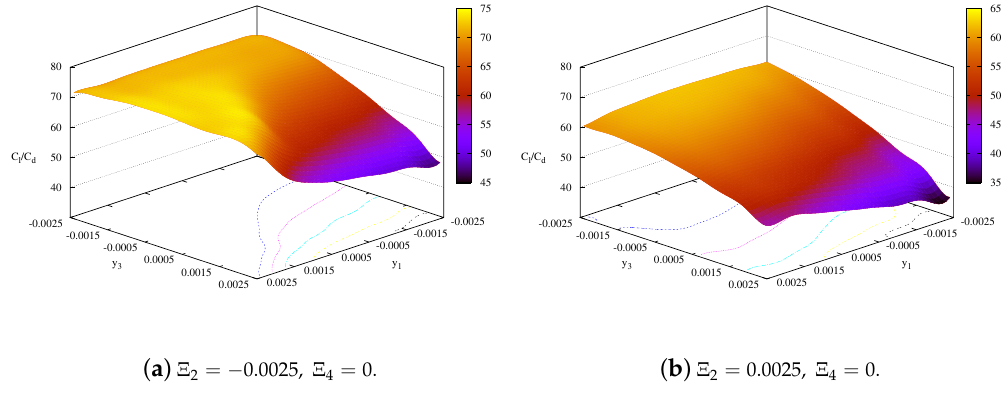
Figure 9. Response surface in the ( Ξ 1 , Ξ 3 ) plane with ( Ξ 2 = − 0.0025, Ξ 4 = 0 ) ( a ) and ( Ξ 2 = 0.0025, Ξ 4 = 0 ) ( b ). These images are taken from Dumont et al.